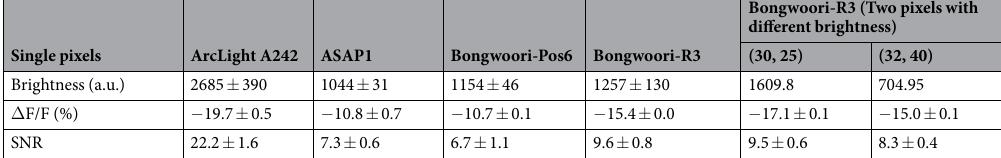
Table 4. Characteristics of GEVIs analyzed from highest correlated pixels. Two individual pixel data shown on the right are from Bongwoori-R3 traces in Fig. 7A (red and blue traces with different fluorescence intensities). All values were analyzed from low-pass filtered traces. Values were shown as mean ± SEM (standard error of the mean). The number of action potentials analyzed; ArcLight: 12, ASAP1: 12, Bongwoori: 11, Bongwoori-Pos6: 11, Bongwoori-R3: 12, all from three cells for each GEVI.